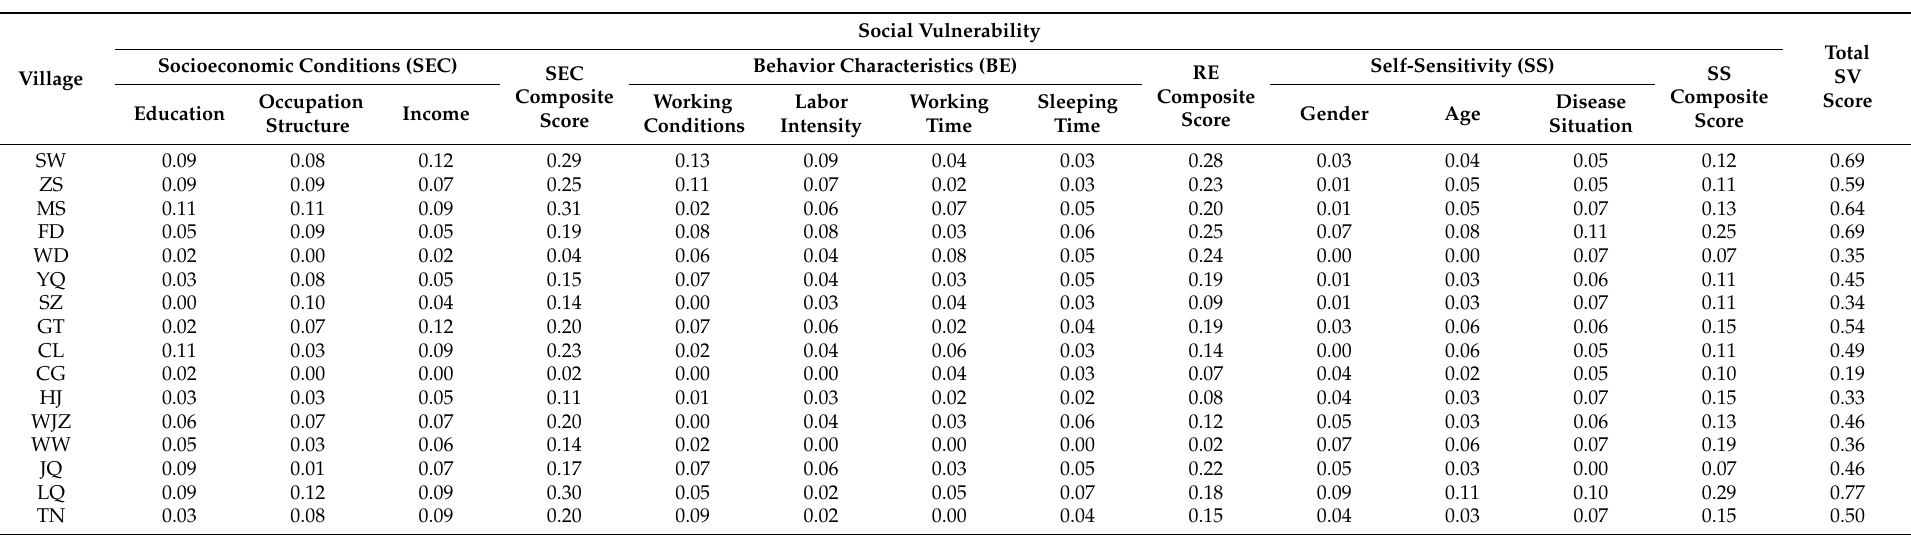
Table 4. Scores of social vulnerability